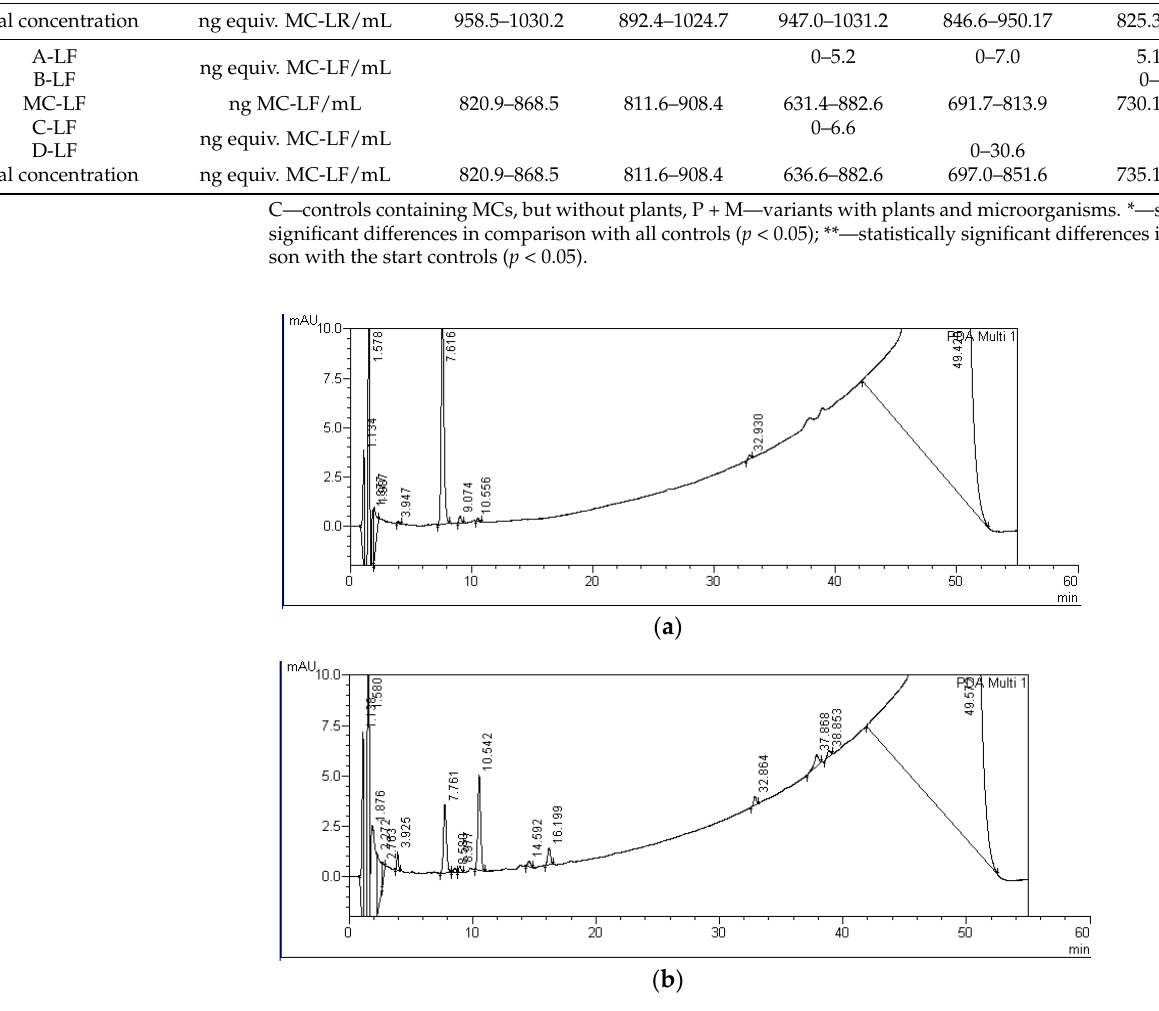
Figure 4. HPLC chromatograms indicating the progressive reduction peaks relevant to MC-RR and growing peaks of MC-RR degradation products after four ( a ) and nine days ( b ) of incubation with S. polyrhiza and associated microorganisms. Peaks and their retention times for MC-RR and its degradation products were as follows: MC-RR — 7.716 – 7.761 min.; C-RR — 8.580 min., D-RR — 10.542 – 10.556 min.; E-RR — 14.592, and F-RR — 16.199 min.